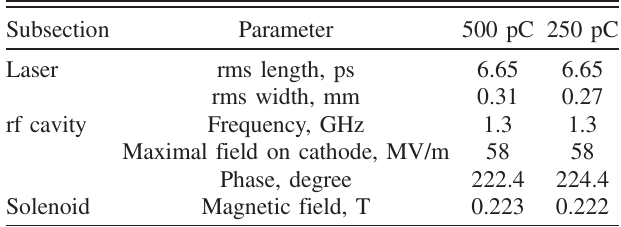
TABLE III. Injector